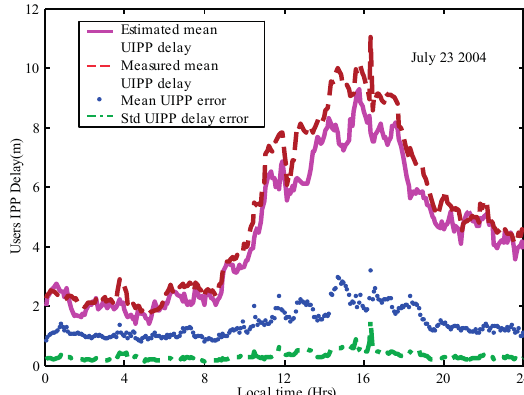
Fig. 4. Estimated mean UIPP delay and mean error using bilinear interpolation technique (23 July